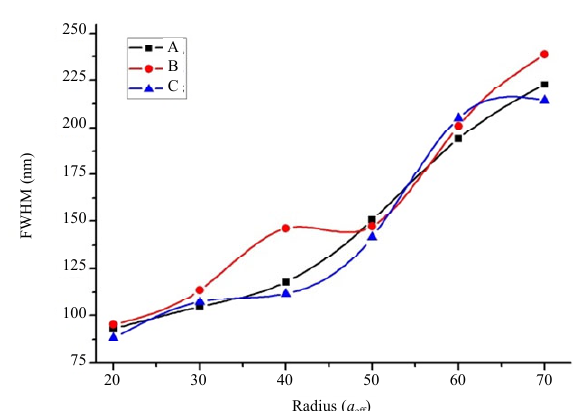
Fig. 6 FWHM as a function of NPs size for Ag 0.50 Fe 0.50 alloy with different number of